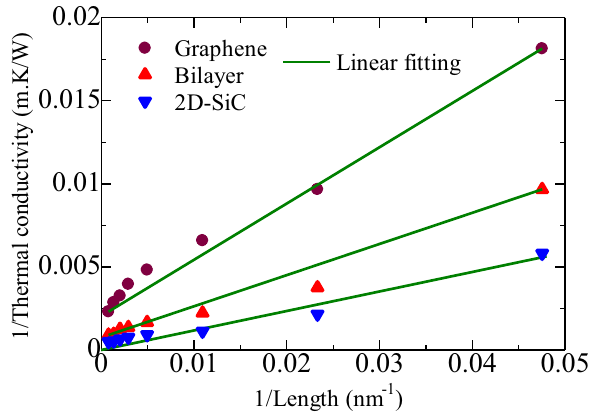
Figure 6. Inverse relation between thermal conductivity and length for extracting infinite length thermal conductivity of graphene, 2D-SiC, and the graphene/2D-SiC